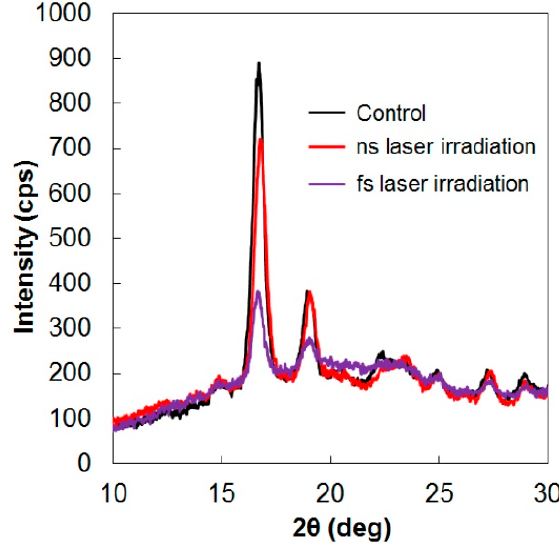
Figure 2. XRD spectra for the surface of PLLA films. Black, red, and purple lines indicate non-irradiated films (control), films irradiated with a nanosecond laser, and films irradiated with a femtosecond laser, respectively. A wavelength of 266 nm was used for both cases femtosecond laser pulses and nanosecond laser pulses.